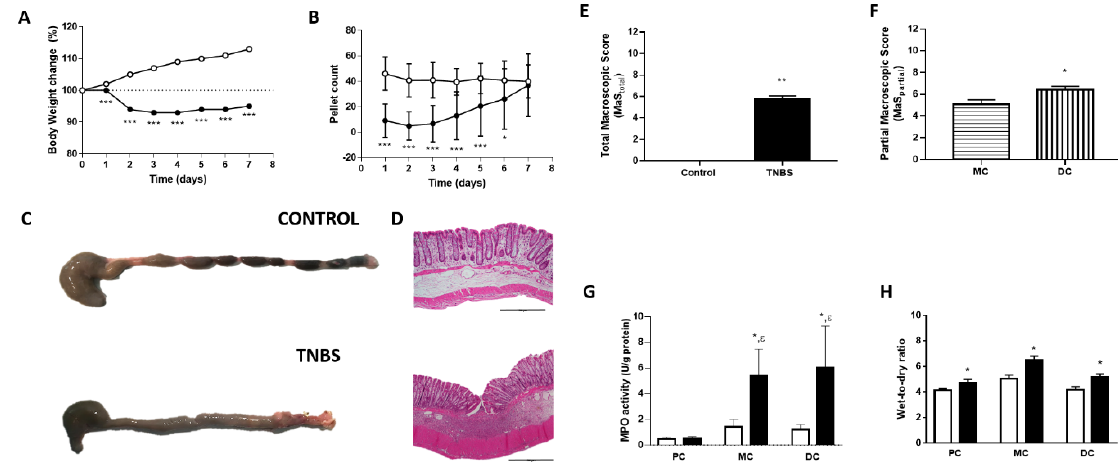
Figure 1. ( A ) Body weight change of control (white circles, n = 28) and TNBS-induced rats (black circles, n = 87). ( B ) Number of fecal pellets of control (white circles, n = 28) and TNBS-induced rats (black circles, n = 87). ( C ) Macroscopic and ( D ) microscopic images from the colons of control and TNBS-induced animals. ( E ) Macroscopic score (MaS) of control (white bar, n = 28) and TNBS-induced rats (black bar, n = 87). ( F ) MaS of the middle colon (MC) and the correspondent distal colon (DC) of TNBS-induced rats ( n = 87). ( G ) Myeloperoxidase (MPO) activity in the proximal colon (PC), middle colon (MC) and distal colon (DC) of control (white bars; PC: n = 12, MD: n = 9, DC: n = 9) and TNBS-induced rats (black bars; PC: n = 16, MD: n = 11, DC: n = 8). ( H ) Wet-to-dry ratio in the proximal colon (PC), middle colon (MC) and distal colon (DC) of control (white bars; PC: n = 29, MC: n = 21, DC: n = 21) and TNBS-induced rats (black bars; PC: n = 20, MC: n = 17, DC: n = 19). * p < 0.05 vs. corresponding controls (except in (D), where * p < 0.05 vs. MC), ** p < 0.0001, *** p < 0.000001 vs. control animals and ε p < 0.05 vs. TNBS-PC.